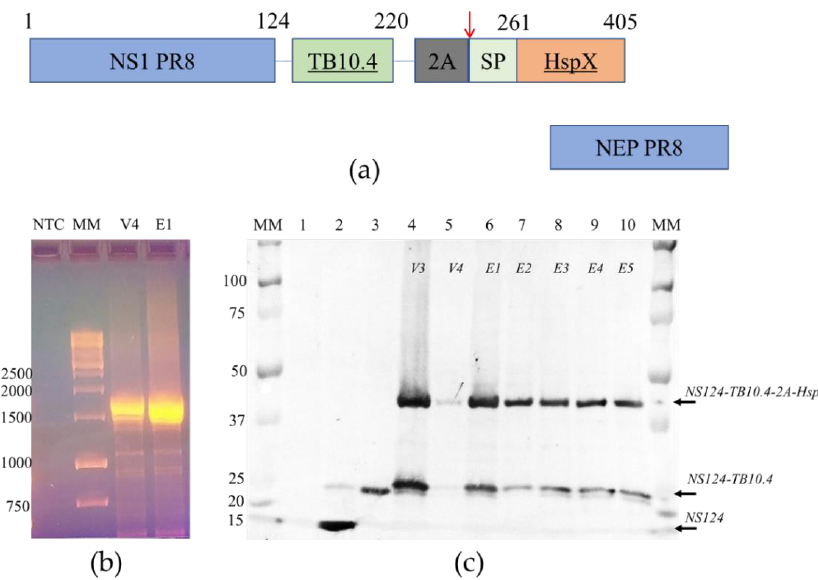
Figure 1. The structure and stability of the chimeric NS gene segment and proteins encoded. ( a ) The structure of NS gene OFRs of the Flu/THSP recombinant virus. The chimeric NS1 protein is synthesized from unspliced mRNA. TB10.4 antigen is directly linked to 124 amino acids of NS1; the HspX antigen is separated by the 2A “autoproteolysis” site and supplied with secretion signal peptide. NEP protein is synthesized from the spliced mRNA; ( b ) Full-length RT-PCR amplicons of the NS gene segment of the Flu/THSP virus passage variants V4 and E1. MM—marker in kb pairs; ( c ) Western blot detection of chimeric NS1 protein in cells infected by the Flu/THSP virus passage variants (lanes 4–10). MM—marker in kDa, lane 1—uninfected cells, lane 2—cells infected with empty virus vector A/PR8/NS124, lane 3—cells, infected with the A/PR8/NS124-TB10.4 recombinant virus carrying only TB10.4 antigen.